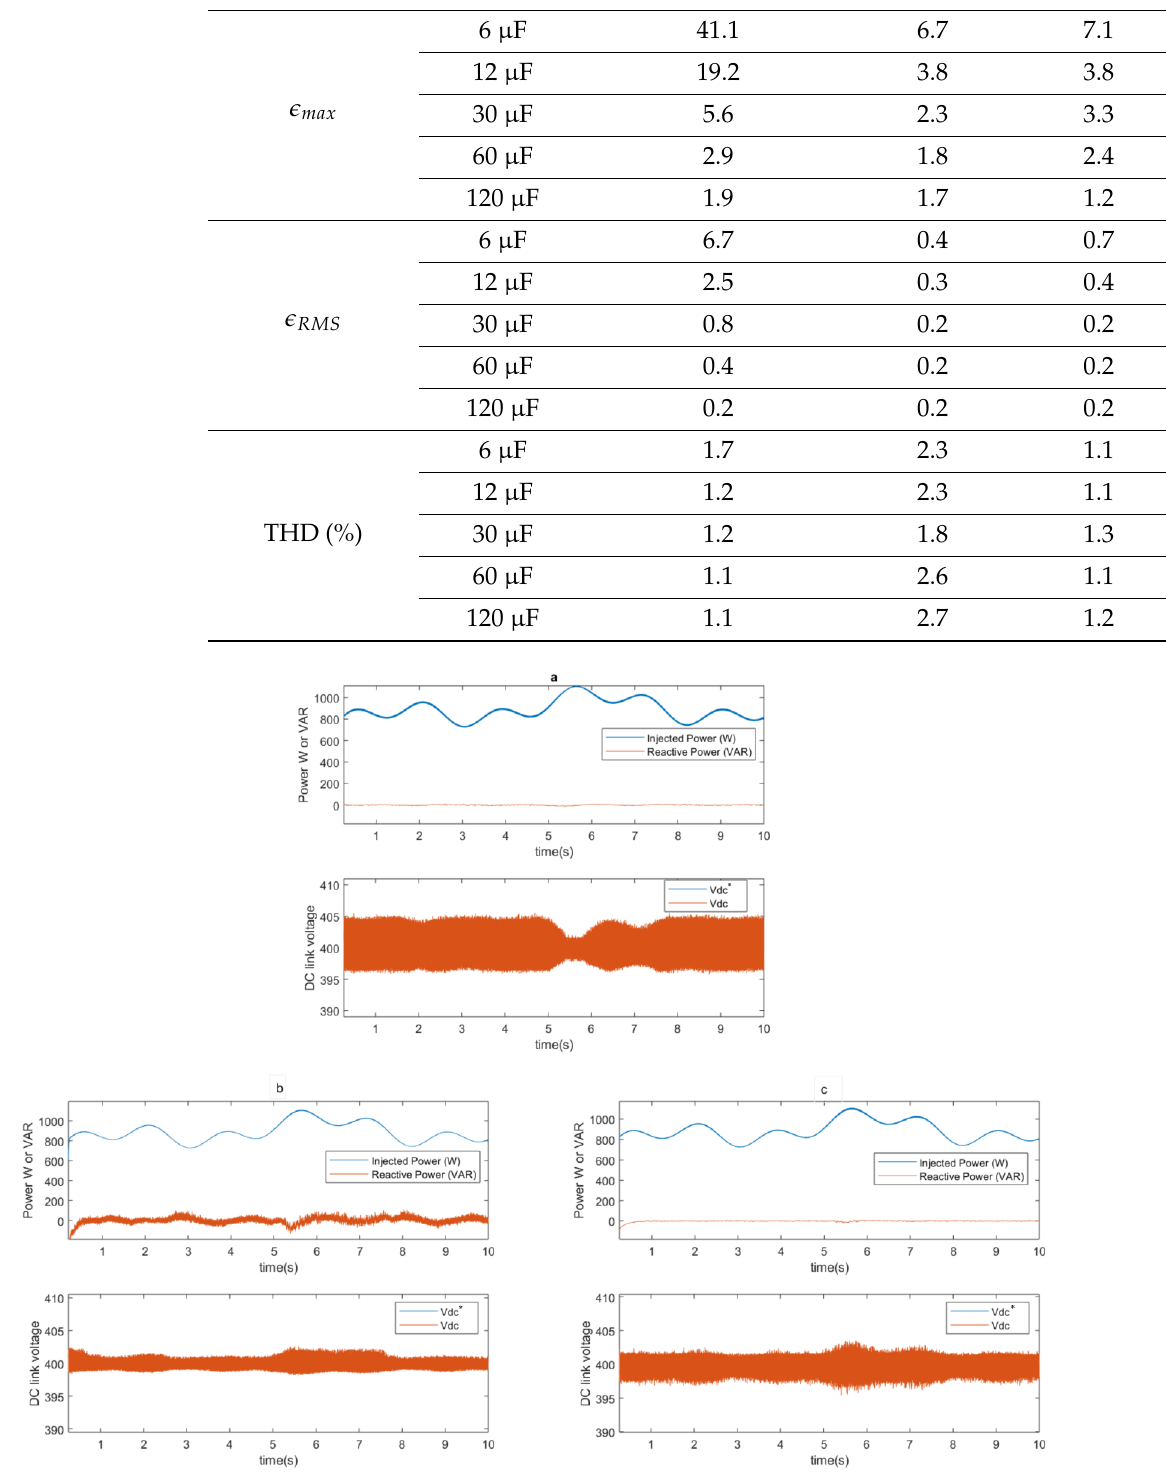
Figure 7. Response of the grid-side converter in the variable regime with C = 30 µ F. ( a ) PI controller; ( b ) SMC1 controller; and ( c ) SMC2